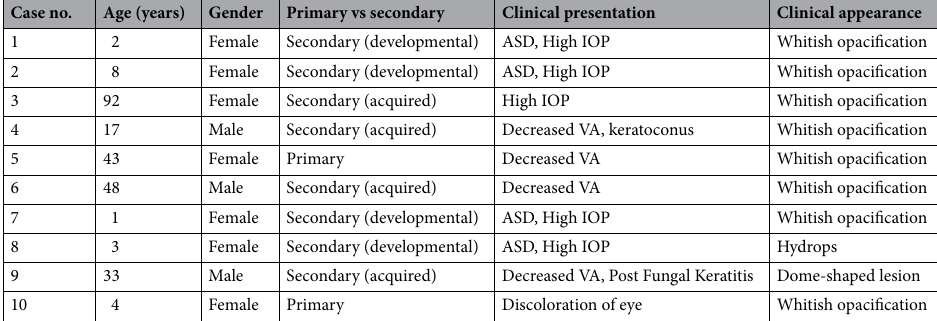
Table 1. Demographic and clinical presentation of patients with corneal myxoma. IOP intraocular pressure, VA visual acuity, ASD Anterior segment dysgenesis.